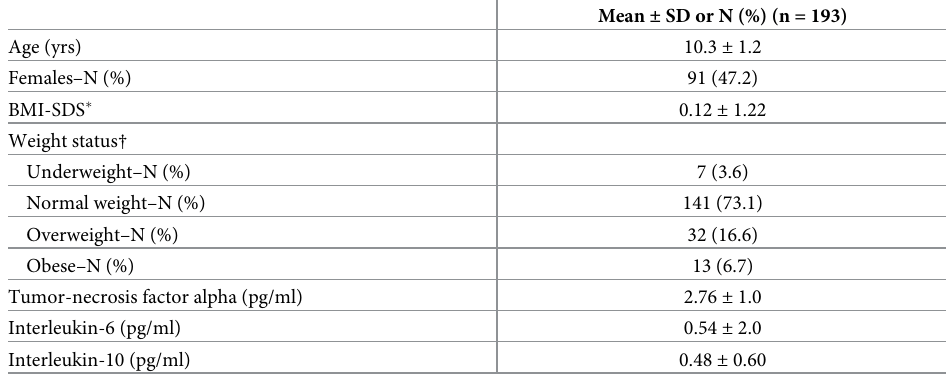
Table 3. Characteristics of TEENDIAB children/adolescents included in the present